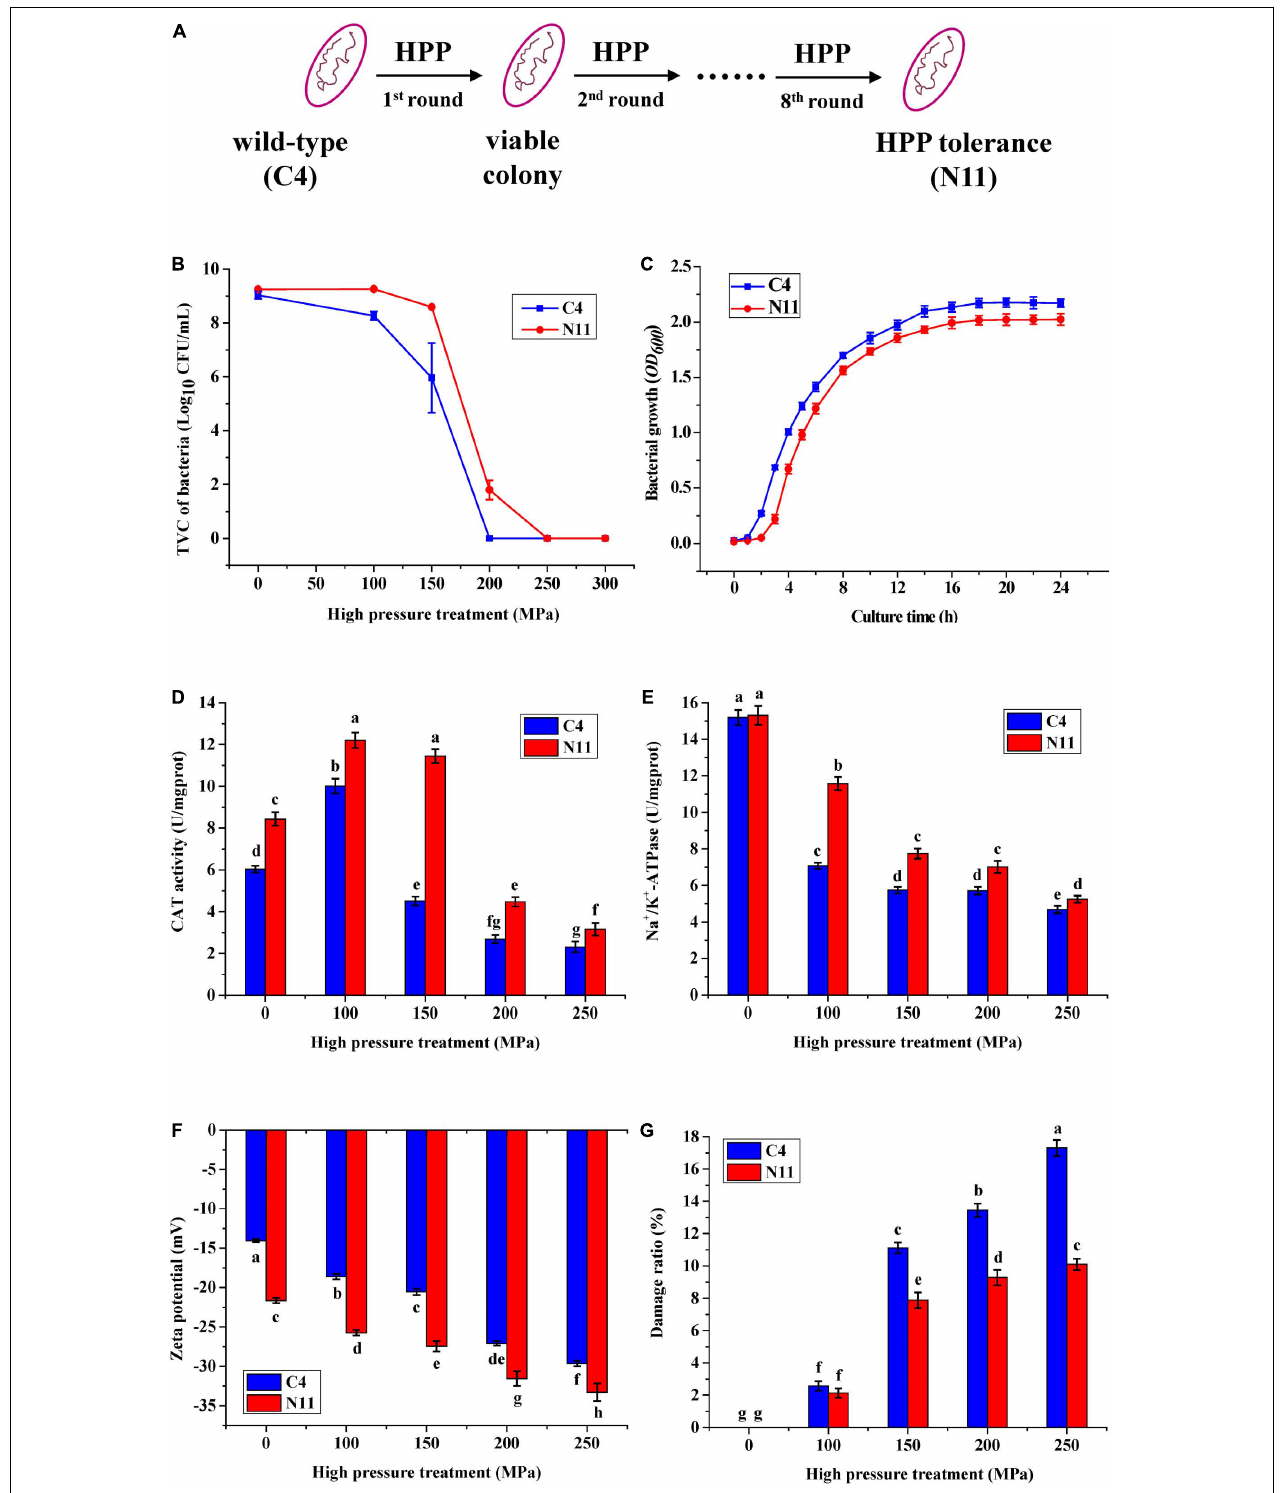
FIGURE 2 | Differences in physiological characteristics between the wild-type (WT) strain and the high-pressure-tolerant strain. (A) A schematic of screening of high-pressure processing (HPP)-tolerant strains using adaptive laboratory evolution. (B) High pressure tolerance of the C4 and N11 strains under high-pressure treatment. (C) Growth curve. (D) Catalase (CAT) activity. (E) Na + /K + -ATPase activity. (F) Zeta potential. (G) Cell membrane permeability was assessed by observing the lactate dehydrogenase (LDH) content.